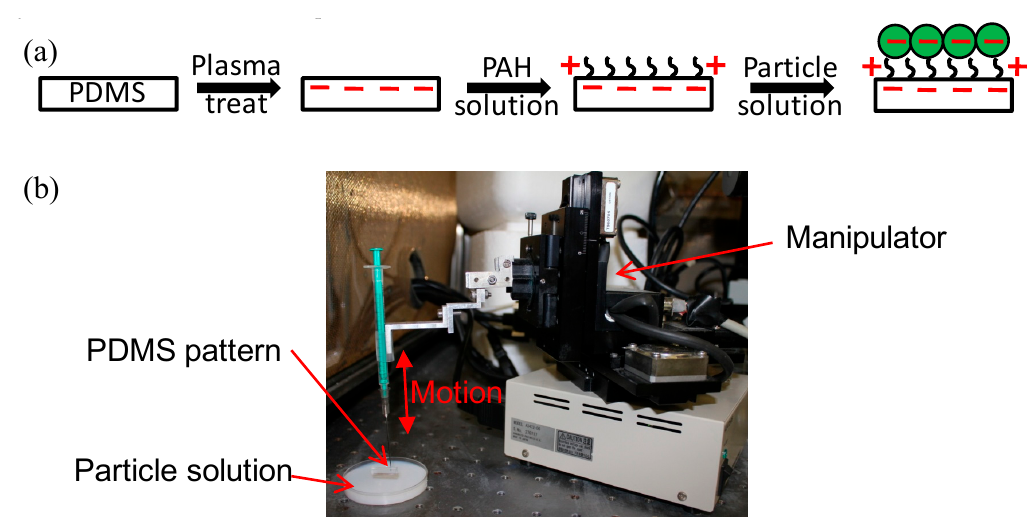
Figure 1. ( a ) Flow chart of nanoparticle (NP) deposition on the wavy-herringbone (HB) polydimethylsiloxane (PDMS) device. ( b ) Experimental setup for NP deposition. The PDMS device was slowly withdrawn from a particle suspension using a home-build manipulator and nanoparticles were deposited into a thin film on the